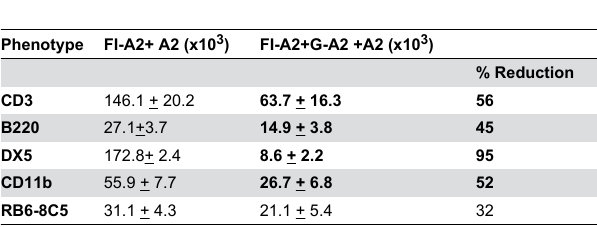
Table 2. Pulmonary leukocytes in FI-RSV and G-A2 peptide vaccinated mice 5 days after RSV challenge a .